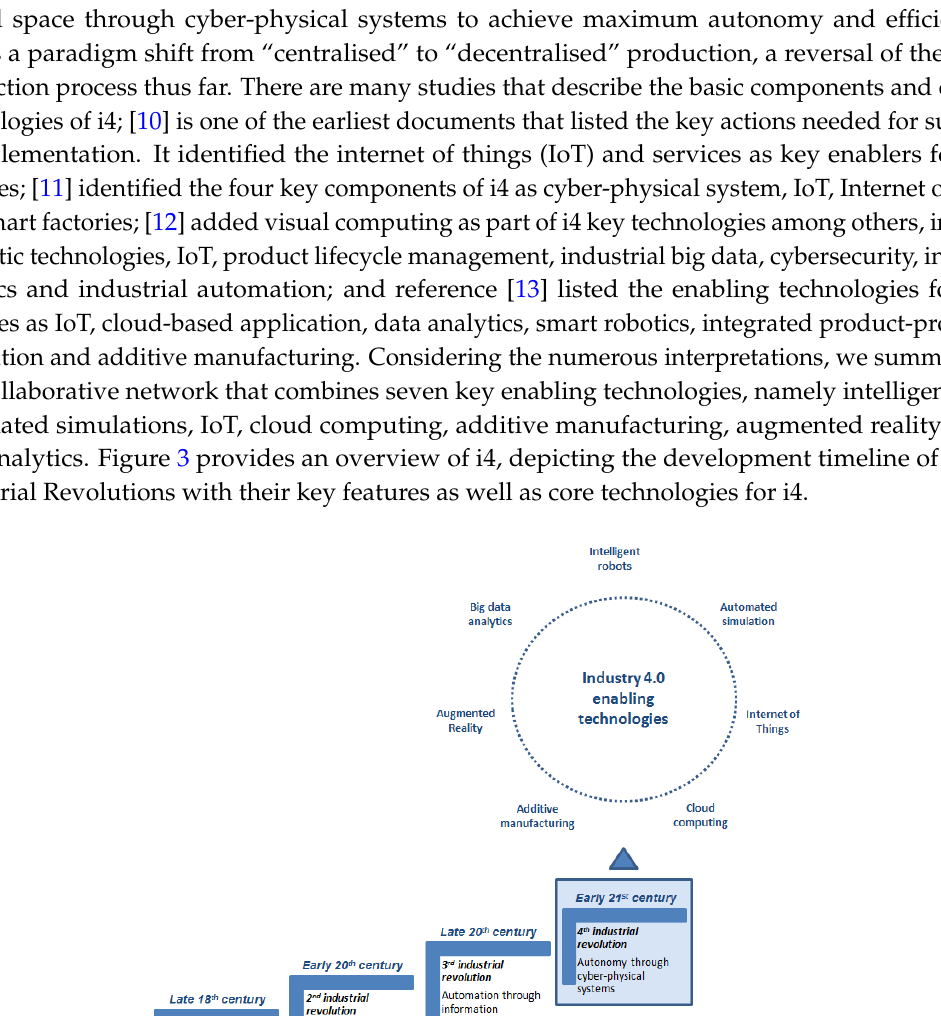
Figure 5. Two-way closed-loop framework for ship design, manufacturing and operation.